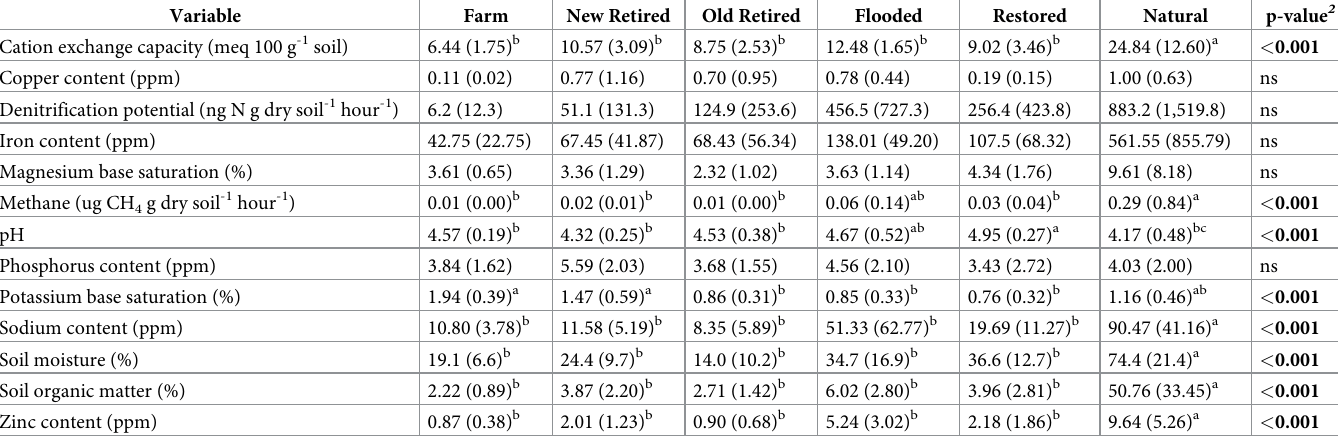
Table 1. Top twelve soil variables that were identified as important predictors of communities of either prokaryotes or microeukaryotes, as determined by canoni- cal analysis of principal coordinates, along with soil moisture.